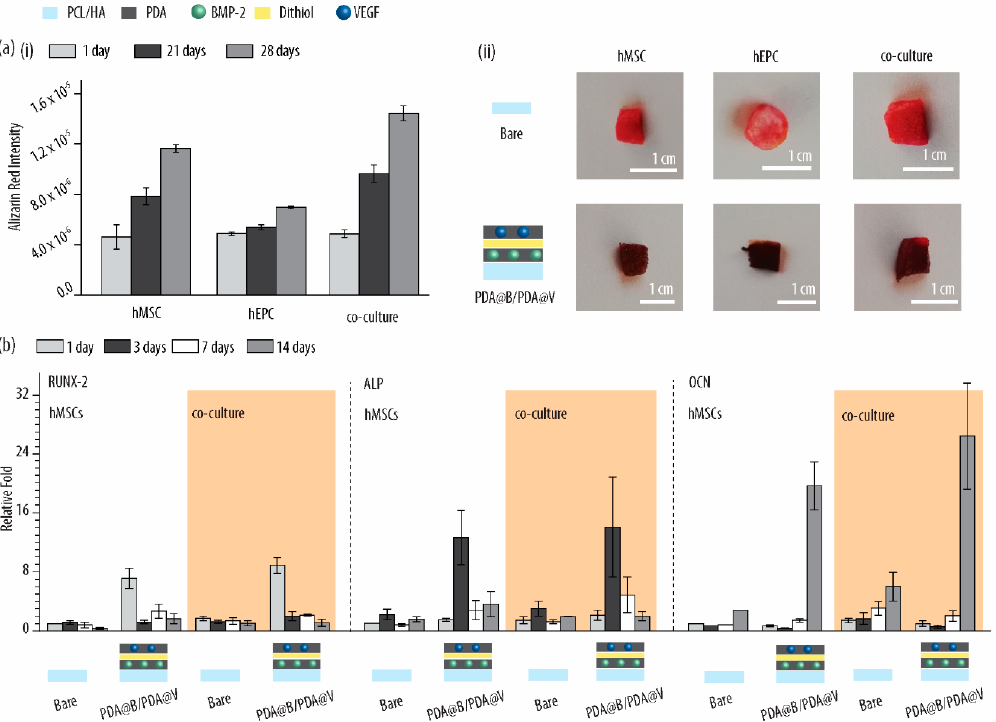
Figure 7. ( a ) ( i ) Alizarin red intensity of human mesenchymal stem cells (hMSCs), human endothelial progenitor cells (hEPCs) and the co-culture of both cells at a 50:50 seeding ratio cultured onto surface coated scaffolds; ( ii ) macroscopic images of the bare and coated scaffolds after 21 days of cell culture; and ( b ) qRT-PCR analysis to assess the expression of osteogenic markers in hMSCs and the co-culture of hMSCs and hEPCs at a 50:50 seeding ratio: PCL/HA-composite scaffolds contain a PDA@B/PDA@V surface coating consisting of two polydopamine (PDA) layers connected by a dithiol linker and entrapping BMP-2 (B) and VEGF (V) growth factors within the first and second PDA layers, respectively.